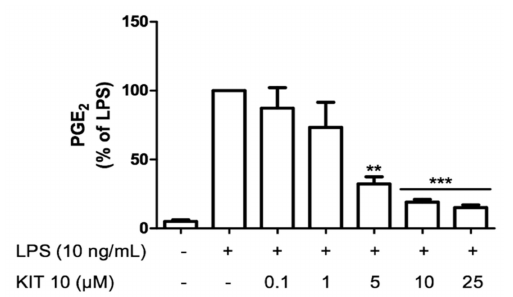
Figure 2. KIT 10 prevents LPS-induced PGE 2 release in primary rat microglial cells. KIT 10 was added 30 min before stimulation with LPS and the amount of PGE 2 in the culture medium was determined after 24 h using an enzyme immunoassay. Each column and error bar represent the mean ± SEM of 3 new cultures/group. ** p < 0.01 and *** p < 0.001 with respect to LPS (One-way ANOVA followed by Newman-Keuls post-test).